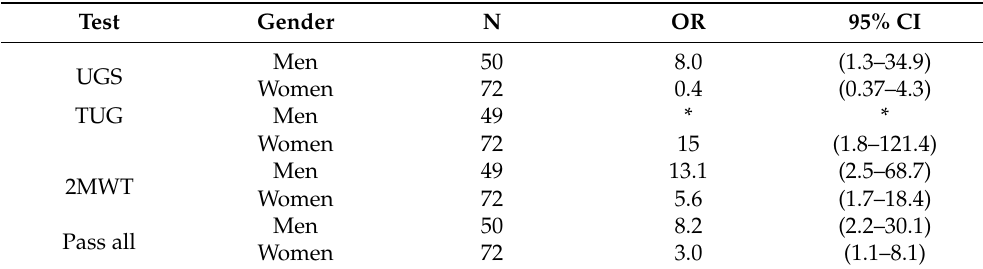
Table 4. Odds ratio (OR) and 95% CI for passing individual and all three mobility tests using HGS/WC cut-off